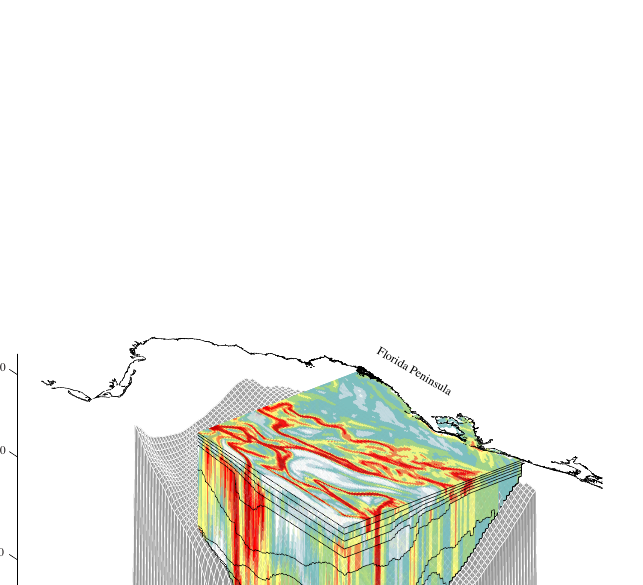
k = 6 (red curve) near the Mississippi River’s mouth. These are compared with those of particles released on the surface layer in Tampa Bay (blue curve) and Charlotte Bay (green curve), whose behavior is very similar to that of particles released on subsurface layer k = 6 and thus are not